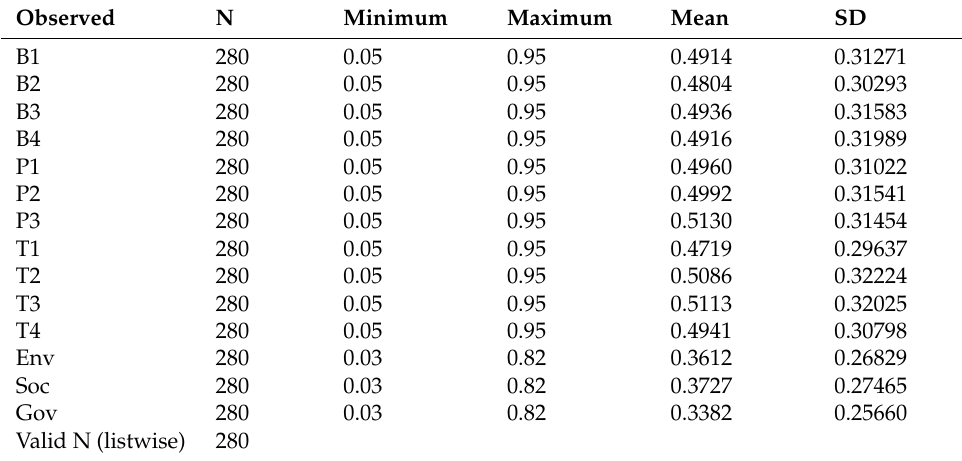
Table 5. The observed variables and standard